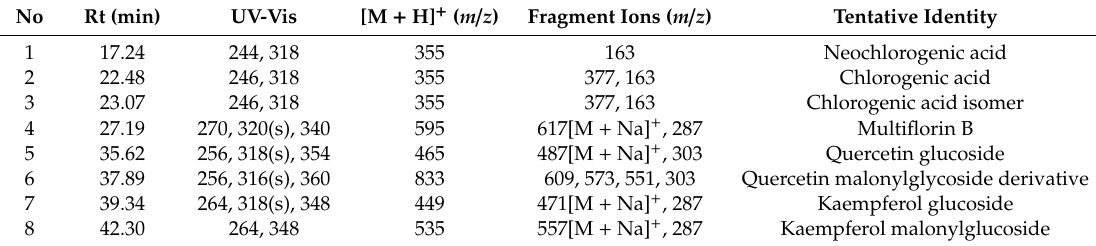
Table 7. Analytical spectrometric data of the major polyphenolic phytochemicals detected in the extracts of M. oleifera leaves.